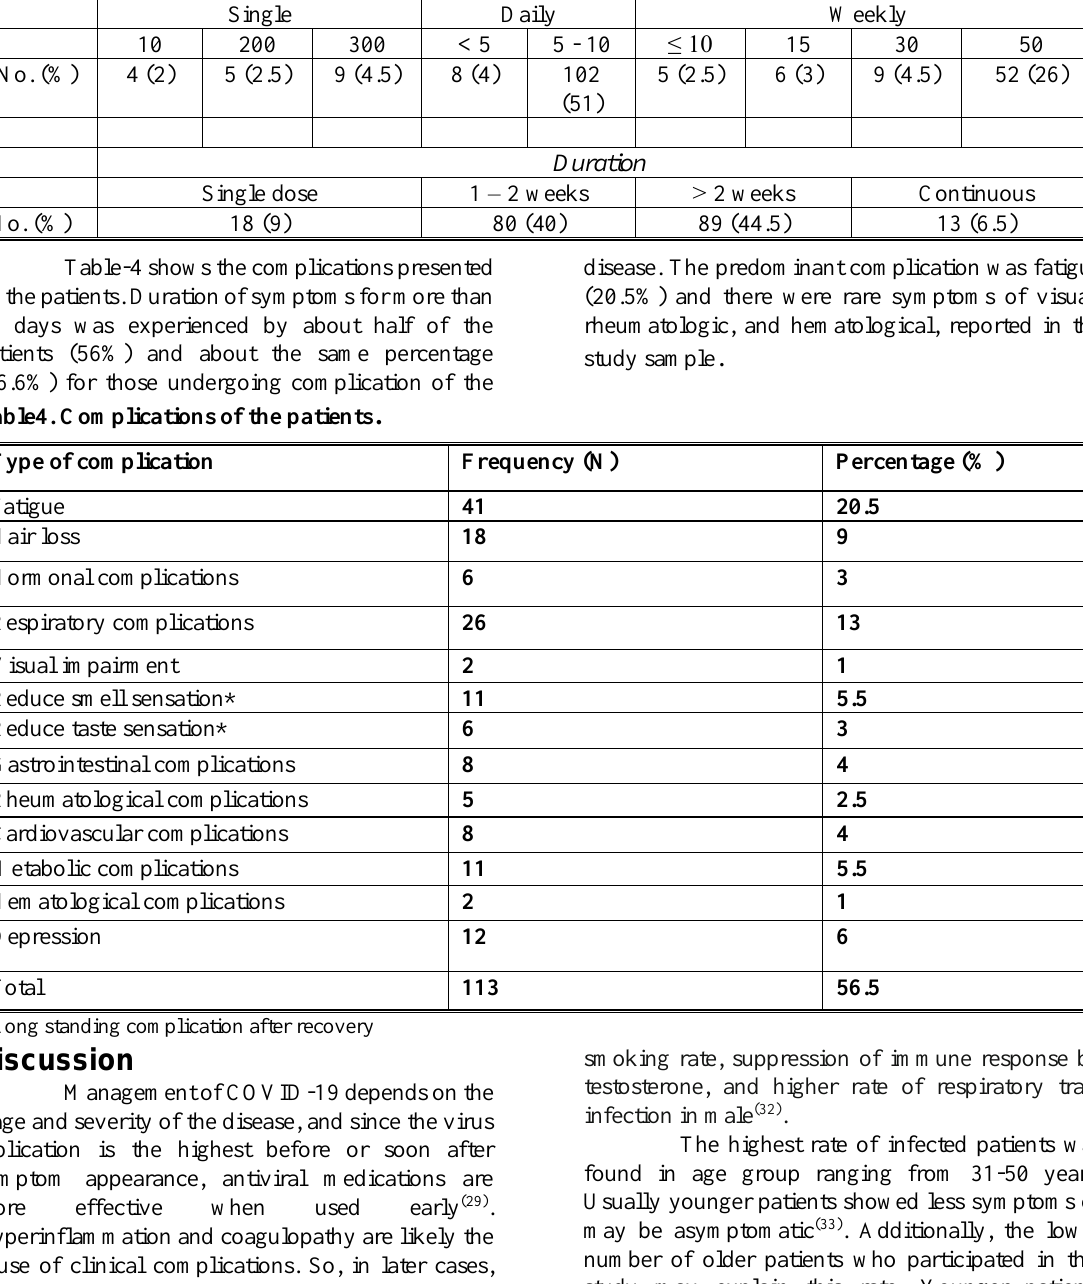
Table3.Vitamin D3 dose and duration. Patients